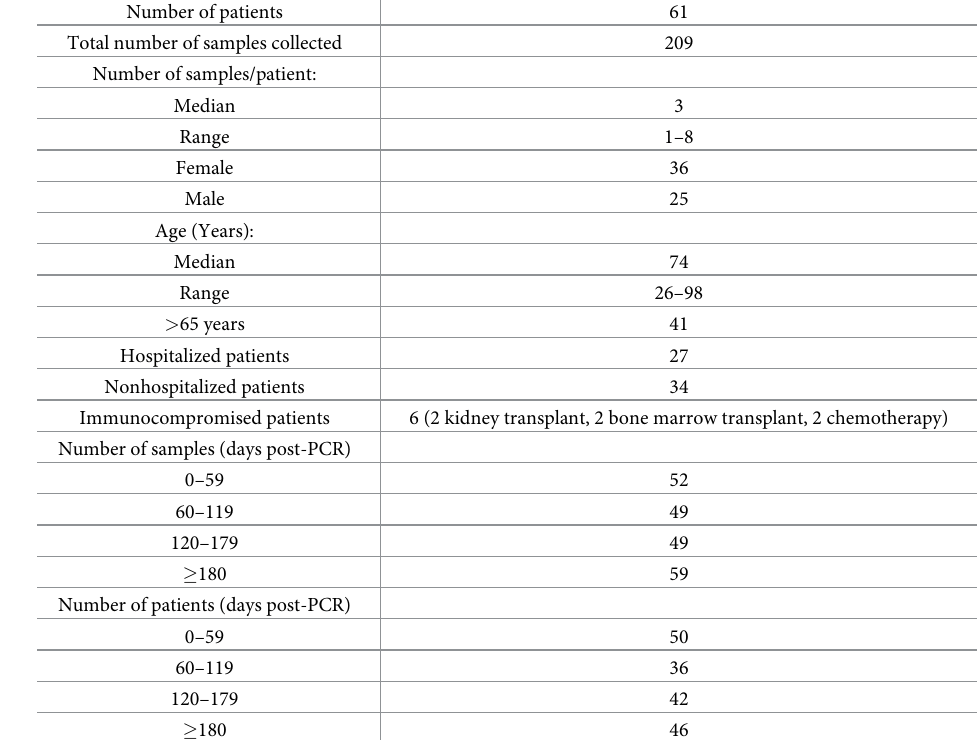
Table 1. Cohort characteristics. Number of